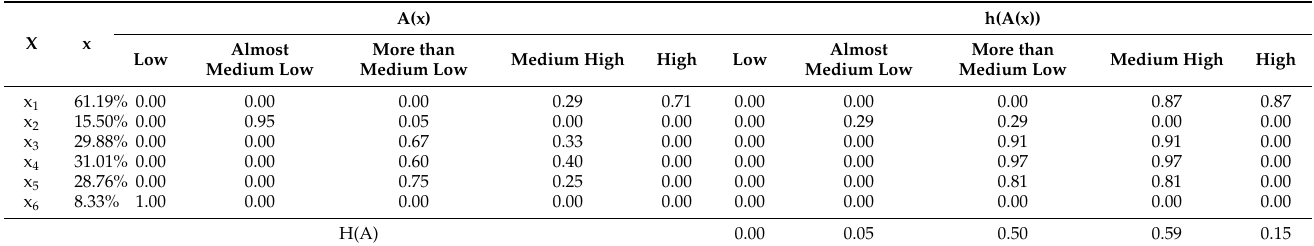
Table 3. Calculus of the fuzziness of the 5 fuzzy sets after splitting the fuzzy set A 2 .